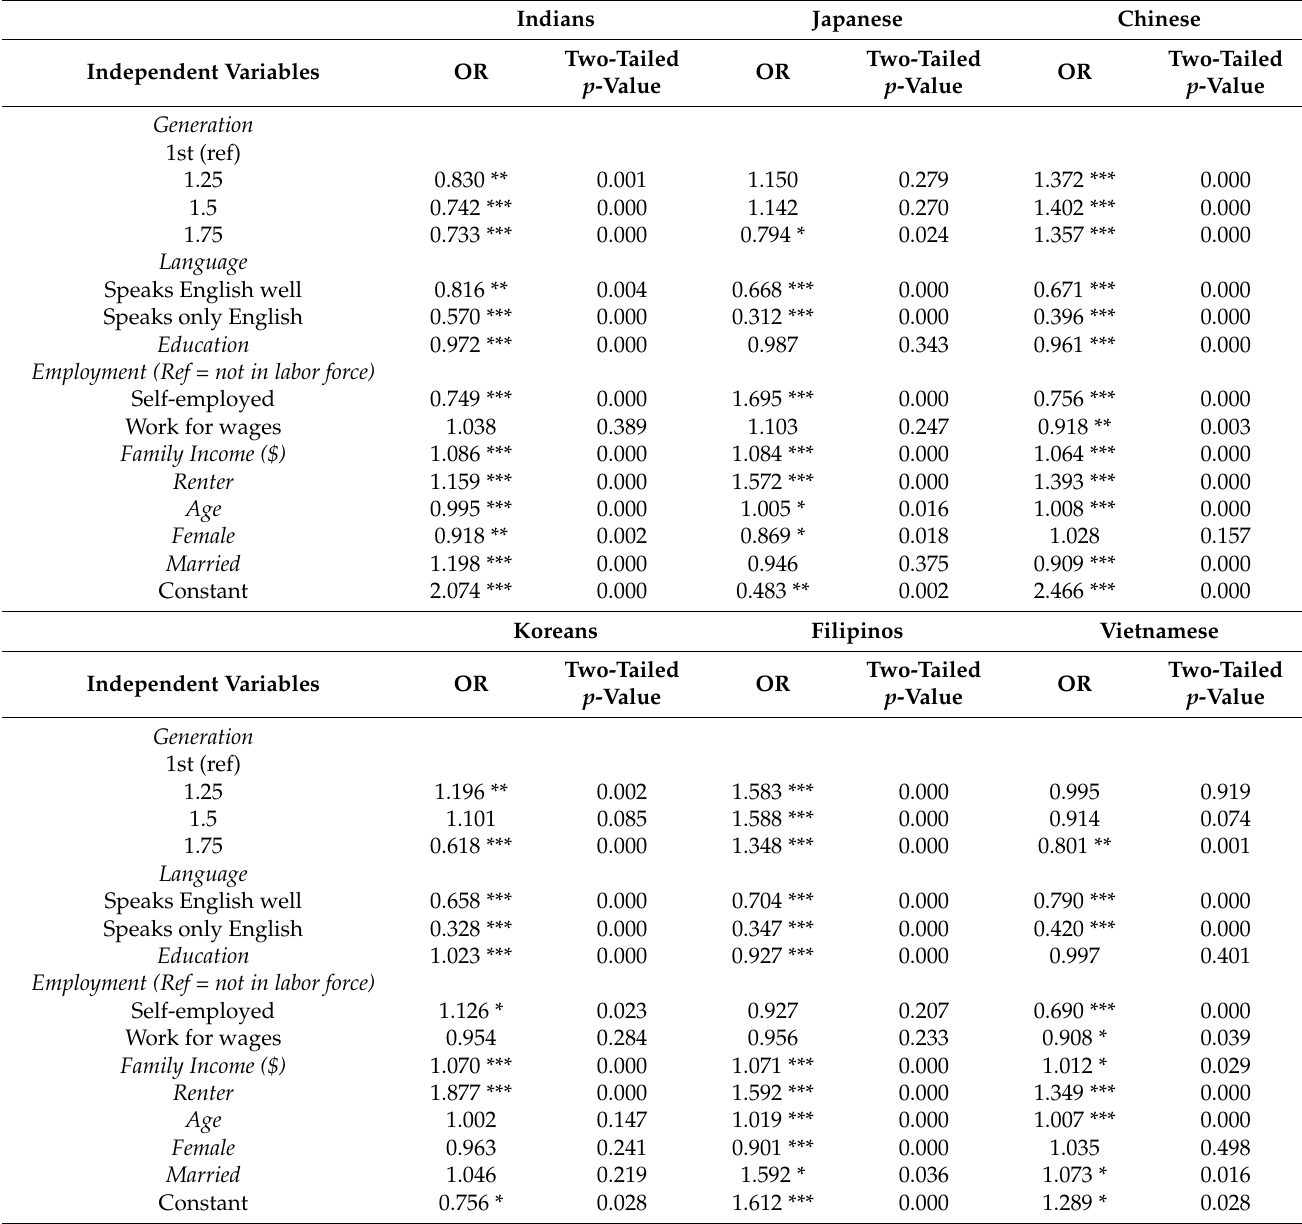
Table 3. Logistic Regression Models Predicting Residence in Ethnic Areas: